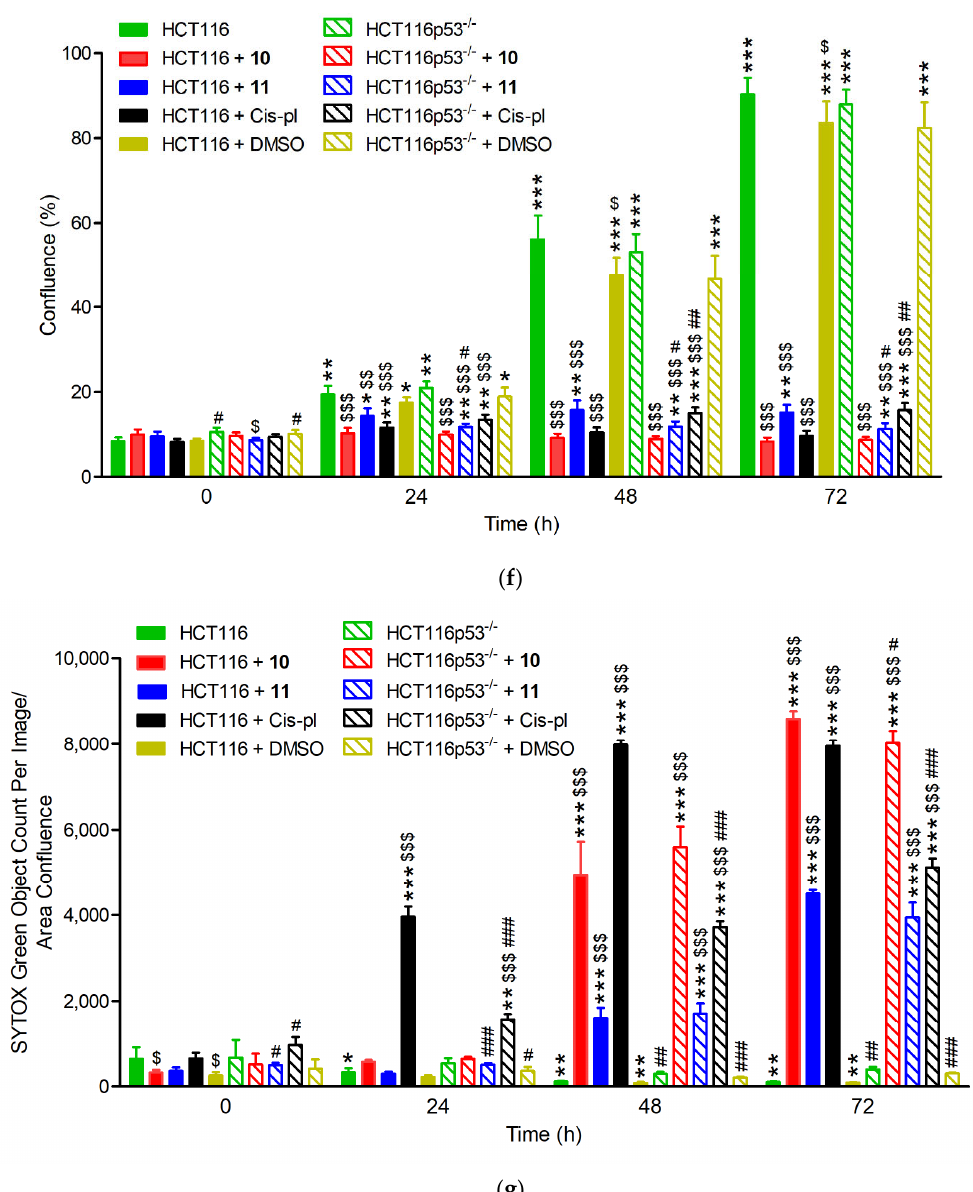
Figure 4. Confluence and cell death measured by IncuCyte live ‐ cell imaging in wild ‐ type (HCT116) and p53 null mutant (HCT116p53 ‐ / ‐ ) cell lines treated with 40 μ M of 10 , 11 , and cisplatin (cis ‐ pl), or dimethyl sulfoxide (DMSO), which was used as a negative control. ( a ) Representative images from the live ‐ cell imaging at 0, 24, 48, and 72 h with or without a drug (UN). The yellow scale bars on the images in the lower left corner represent 400 μ m. The confluence was drastically reduced and the cell death (measured with SYTOX Green Dead Cell Stain and calculated as the percentage of the total cell population) was significantly increased in the HCT116 ( b , d ) and HCT116p53 ‐ / ‐ cells ( c , e ) after 10, 11 , or cis ‐ pl treatment compared with the untreated or DMSO ‐ treated cells. ( f , g ) Analysis of confluence and cell death after treatment for 24, 48, and 72 h with 40 μ M of 10 , 11 , and cis ‐ pl, or DMSO. Data are presented as means ± SDs of four replicative wells. The statistical analysis was performed using one ‐ way ANOVA, followed by the post ‐ hoc Tukey’s test (*, p < 0.05; **, p < 0.01; ***, p < 0.001 treated cells vs. corresponding untreated cells in time 0 h; $, p < 0.05; $$, p < 0.01; $$$, p < 0.001 treated cells vs. corresponding untreated cells in the same time) or two ‐ tailed Student’s t ‐ test (#, p < 0.05; ##, p < 0.01; ###, p < 0.001 HCT116p53 ‐ / ‐ cells vs. corresponding HCT116 cells).